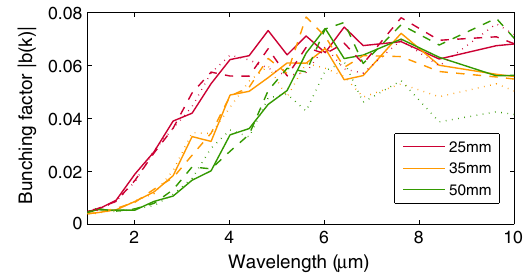
FIG. 7. Bunching factor for different settings of BC2, with R 56 ranging from 25 mm to 50 mm. Chirp between BC1 and BC2 is changed to maintain the same total compression factor (peak current of 0.5 kA) for each case. Measured SES at the laser heater was 12 keV (solid lines), 12.5 keV (dashed lines), and 13 keV (dotted lines).